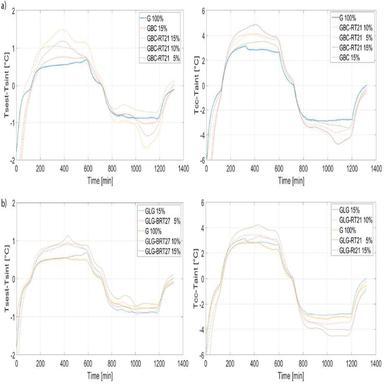
a)Ts,est-Ts,int and of Tcc-Ta,int of GBC 15 % and GBC-RT21 compounds at the various percentage and b) GLG 15 % and GLG-RT27 compounds at the various percentage.